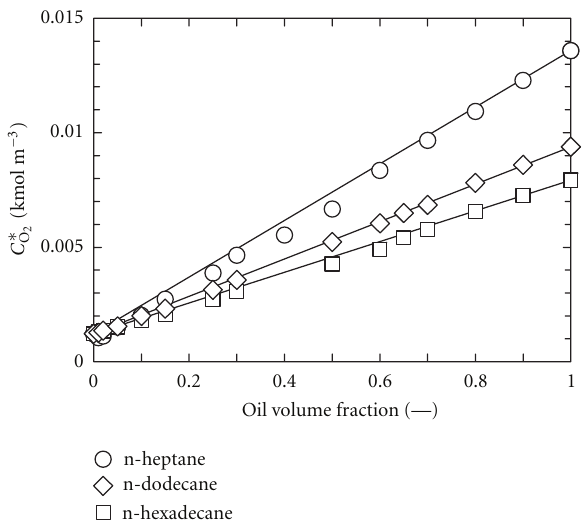
Figure 4: E ff ect of oil volume fraction on O 2 solubility at a partial pressure of 101325 Pa.